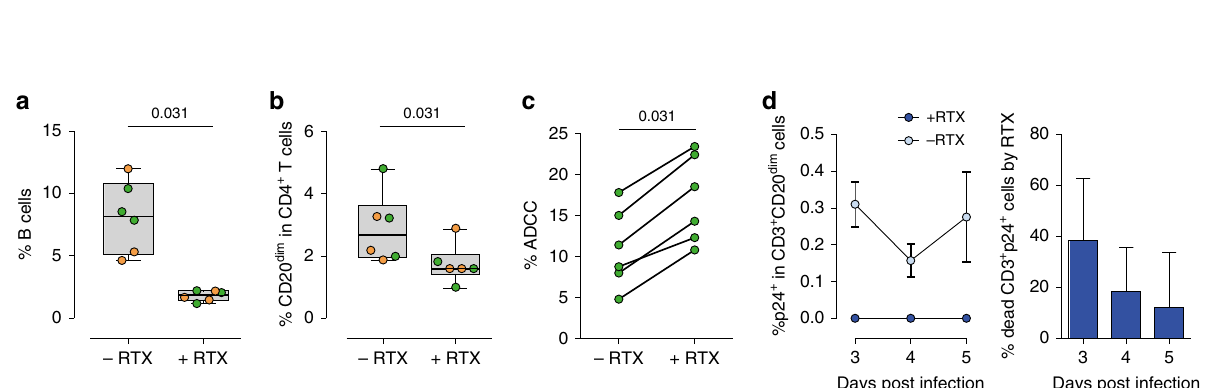
Fig. 6 Rituximab treatment eliminates infected CD20 dim CD4 + T cells and reduces HIV-1 infection in vitro. a , b Isolated PBMCs from uninfected donors (green) and ART-suppressed HIV + patients (orange) were treated with Rituximab (RTX) or antibody control for 48 h. Cell death was assessed by fl ow cytometry using the gating strategy shown in Fig. 1a. Panels represent percentages of B cells ( a ) or CD20 dim in CD4 + T cells ( b ) for n = 3 uninfected donors and n = 3 ART-suppressed patients (#56 – 58). Median values and min – max ranks are represented. c Isolated CD4 + T cells incubated with Rituximab or antibody control were used as a target in combination with isolated autologous NK cells. The percentage of ADCC was measured by the reduction of eFluor670 staining by fl ow cytometry using the gating strategy shown in Fig. S6. Summary results for six uninfected donors are represented. d PBMCs from n = 3 uninfected donors were infected with the HIV strain NL4.3 and treated with Rituximab for different periods of time. Percentages of infected cells (p24 + ) in CD20 dim CD3 + T cells with (dark blue) or without (light blue) Rituximab are represented in the left panel (mean ± SEM). The percentage of dead infected cells induced by Rituximab is shown in the right panel, which represents the difference in the proportion of infected cells between Rituximab-treated cells versus Rituximab non-treated cells (mean ± SD). Flow gating strategy used for this analysis is shown in Fig. 5a. All comparisons were performed using the Wilcoxon test. Data underlying this Figure are provided as Source Data fi